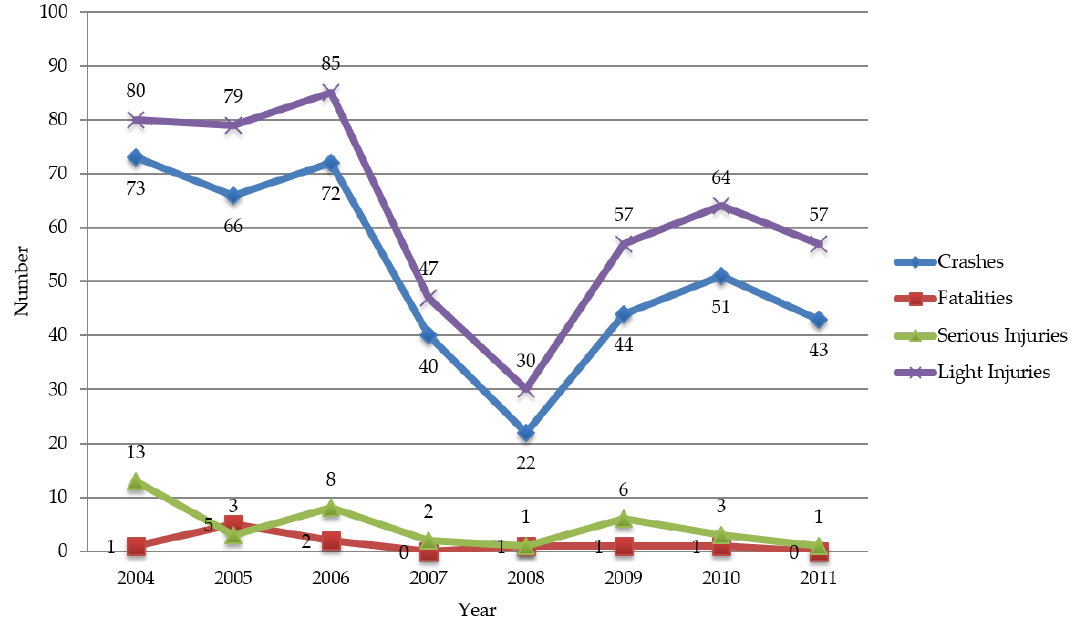
Figure 3. Road crashes and casualties in the area of influence of all 19 speed cameras in the study.